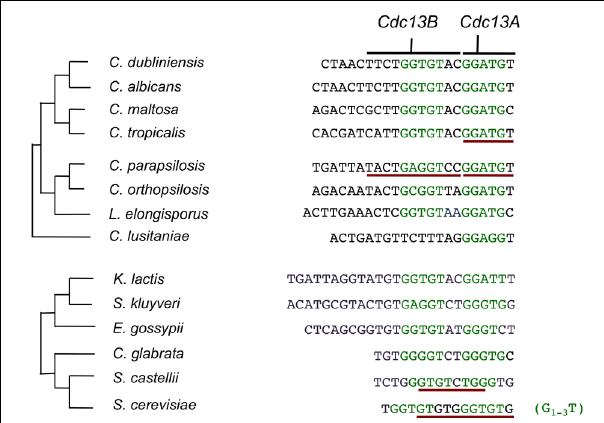
FIGURE 5 | The telomere repeat units of Saccharomycotina yeast and the putative or experimentally determined Rap1 and Cdc13 target sites. The phylogeny of Candida spp. and that of Saccharomyces and Kluyveromyces spp. are displayed separately along with the telomere repeat unit in each species. The putative Rap1 half-sites are displayed in green and the nucleotides that have been experimentally shown to contact Cdc13 or be required for Cdc13 binding are underlined in dark red. Note that C. lusitaniae has an unusual telomere repeat unit that carry just one obvious candidate half site for